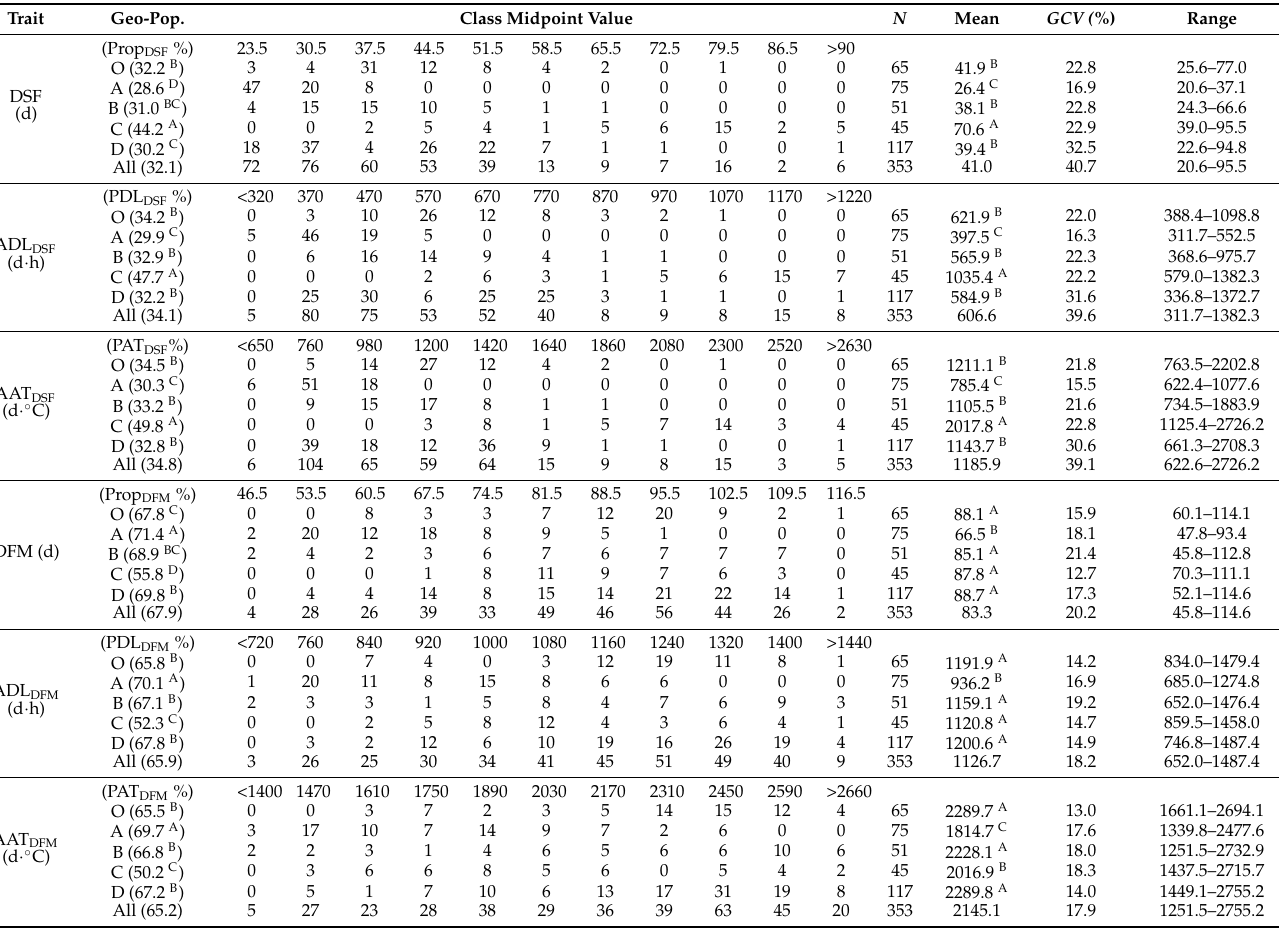
Table 1. Variation of growth period traits, accumulative day length and accumulative active tempera- ture among geographic subpopulations in the World Soybean Germplasm Population